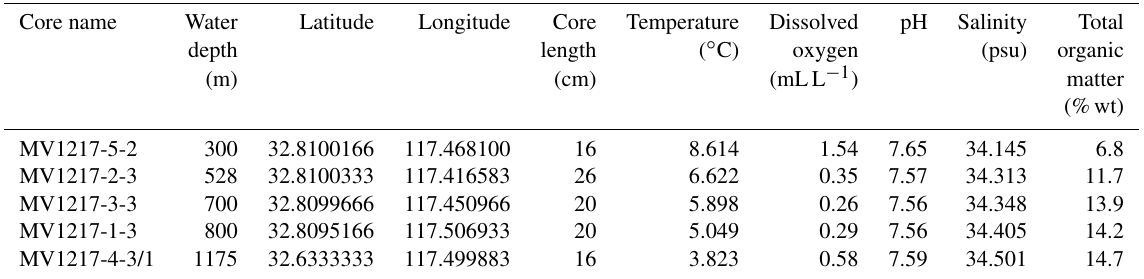
Figure 1. Map of cores used in this study. The cores were collected along a transect perpendicular to shore at the following water depths: 300, 528, 700, 800, and 1175m. Core top samples were analyzed for all cores. Cores MV1217-2-3, MV1217-1-3, and MV1217-4-3/MV1217-4-1 were analyzed down core. Table 1. Data for cores used in this study. Temperature, dissolved oxygen, pH, and salinity were measured in bottom water directly above each coring